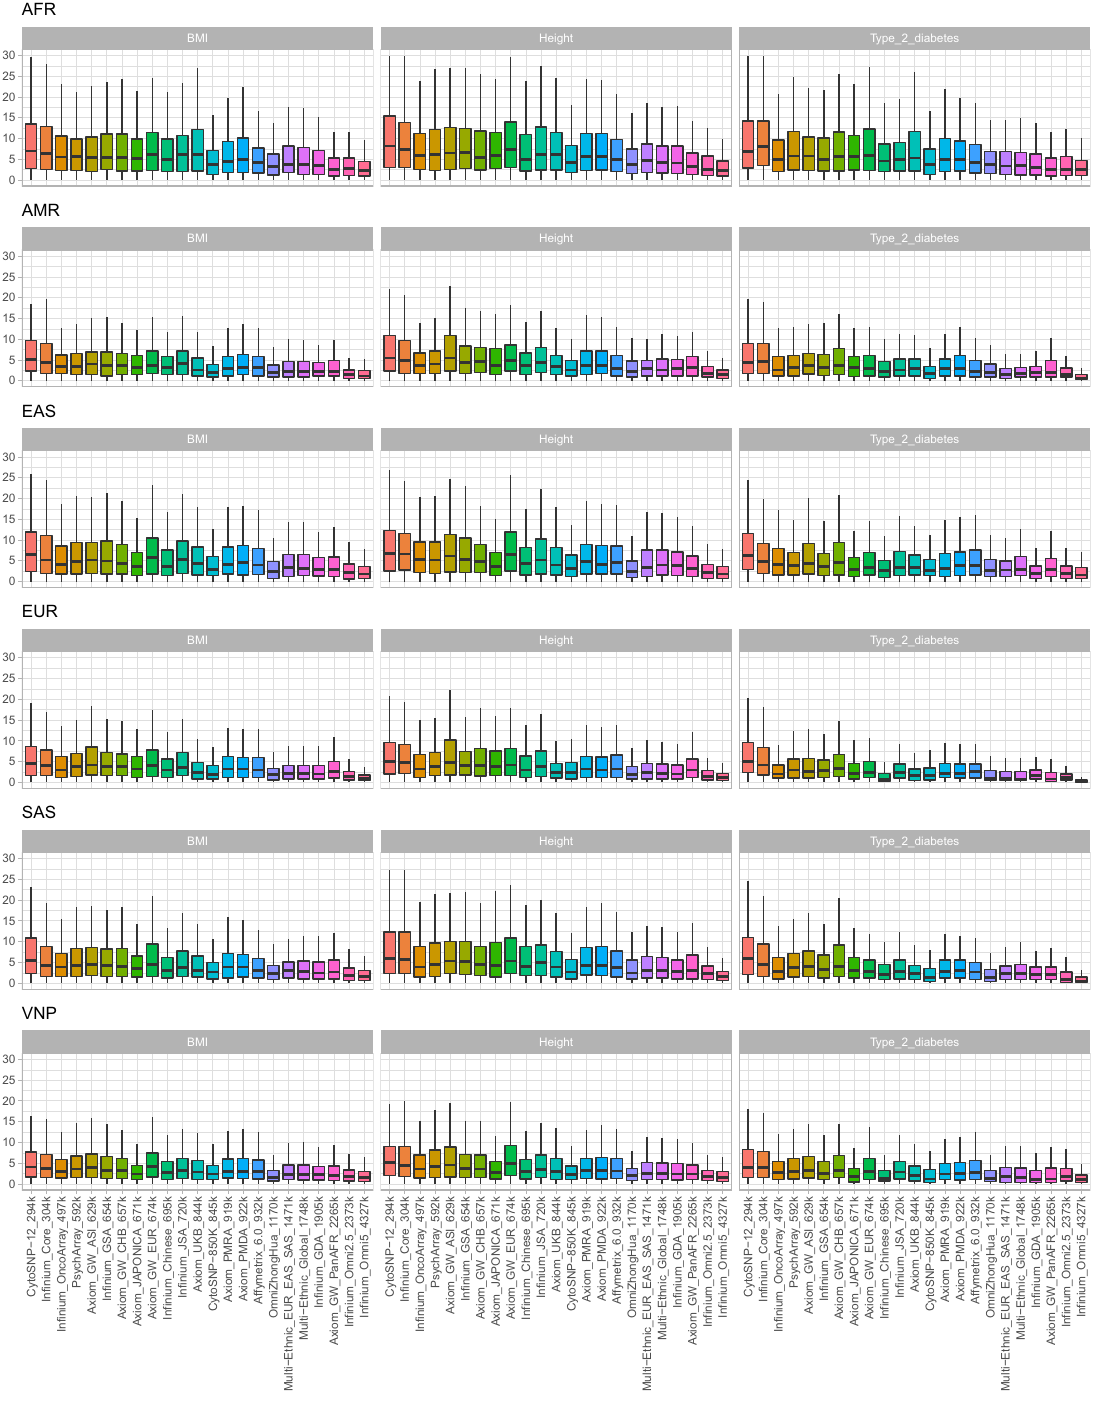
Figure 4. The absolute difference of percentile ranking between PGS estimated from imputed genotyping data of 23 SNP arrays and PGS estimated from WGS in six different populations. The figure shows results of three phenotypes including height, BMI, and type two diabetes with PRsice p-value setting of